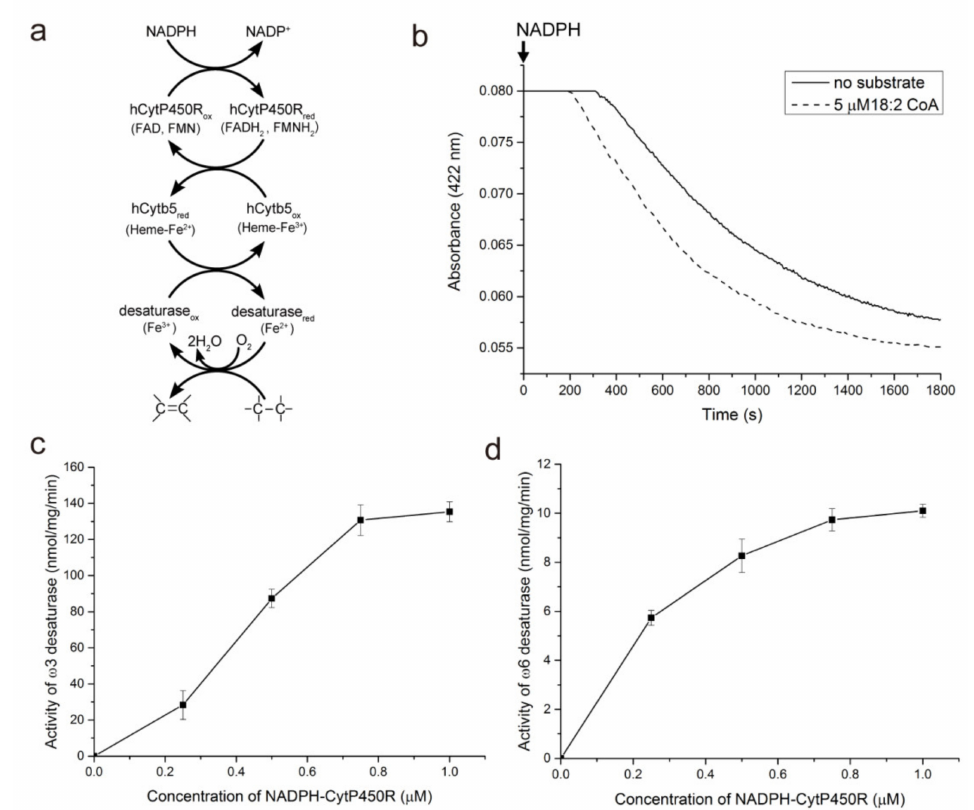
Figure 3. The principle of electron transport and dependence of NADPH-initiated desaturase ac- tivity on the concentration of cytochrome P450 reductase in the reconstituted system: ( a ) The reac- tion scheme used to monitor desaturase activity. NADPH and human cytochrome P450 reductase (hCytP450R) were used to rapidly reduce human cytochrome b5 (hCytb5) and in turn the desaturase. ( b ) Representative progression curves for the reaction between ω 3 desaturase and 18:2 CoA sub- strate. Note that the re-oxidation of Cytb5 was accelerated by the addition of substrate versus air oxidation in the blank. ( c ) Dependence of ω 3 desaturase activity on the concentration of CytP450R. ( d ) Dependence of ω 6 desaturase activity on the concentration of